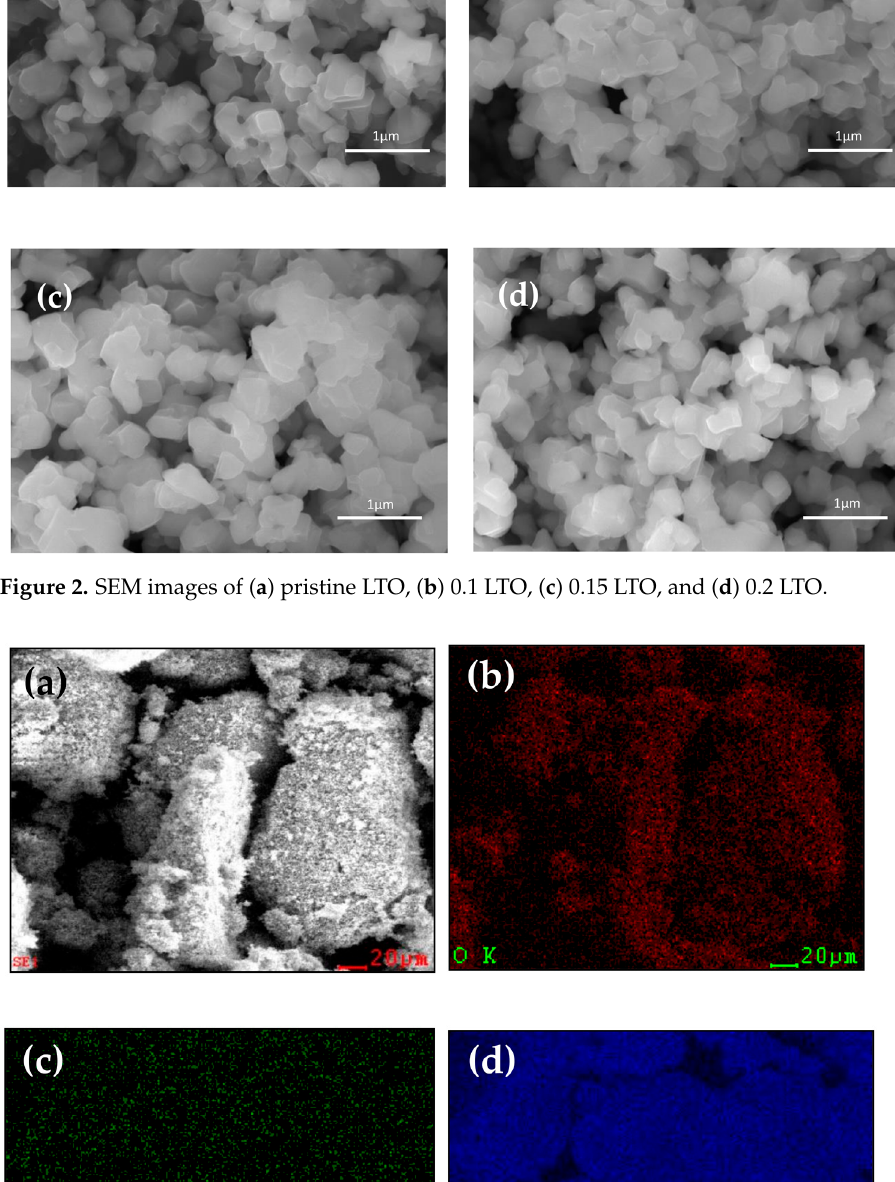
Figure 3. SEM/EDS images of 0.2 LTO; ( a ) images of 0.2 LTO, ( b ) O element, ( c ) I element, and ( d ) Ti element.